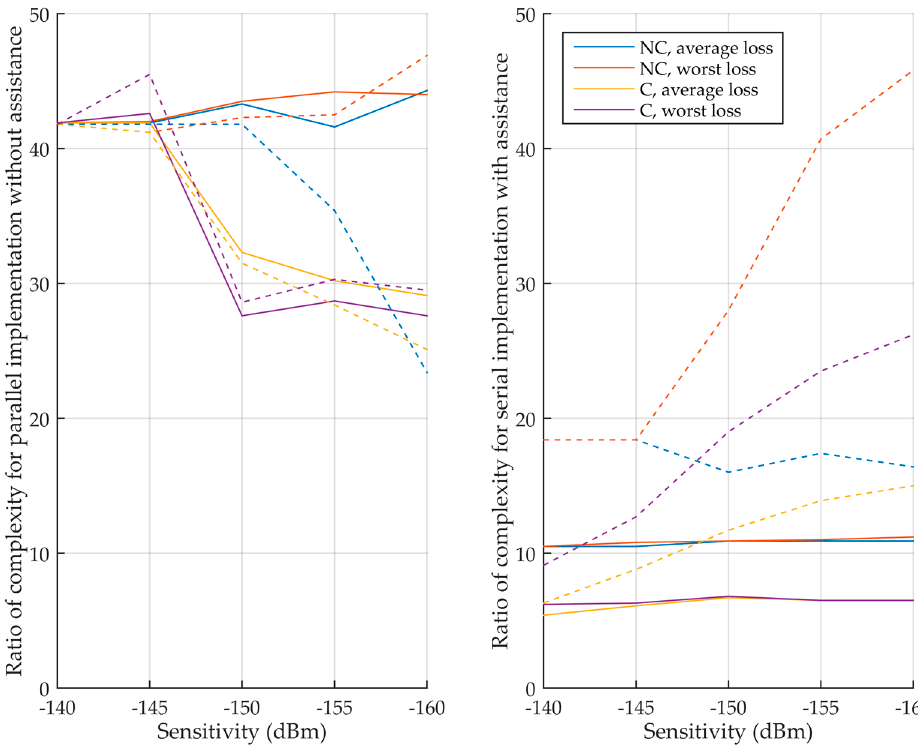
Figure 14. Ratio of complexity (product of processing time ratio and memory ratio) between the E5 signal and the E1 signal with a sampling frequency of 4.096 MHz. ( Left ) without assistance, ( right ) with assistance. Solid curves do not consider the input memory, while dashed curves consider the input memory. Table 22. Final ratio of complexity (product of processing time ratio, memory ratio and frequency bins ratio) between the E5 and E1 signals obtained as the product of Tables 10 and 11. Top rows do not consider the input memory, while bottom rows consider the input